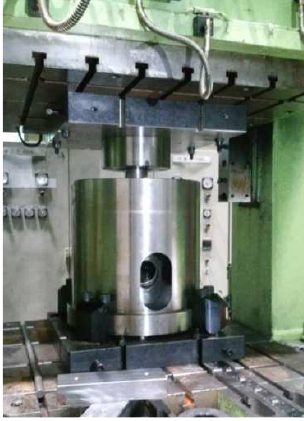
Fig. 1. ECAP die with 800ton press.